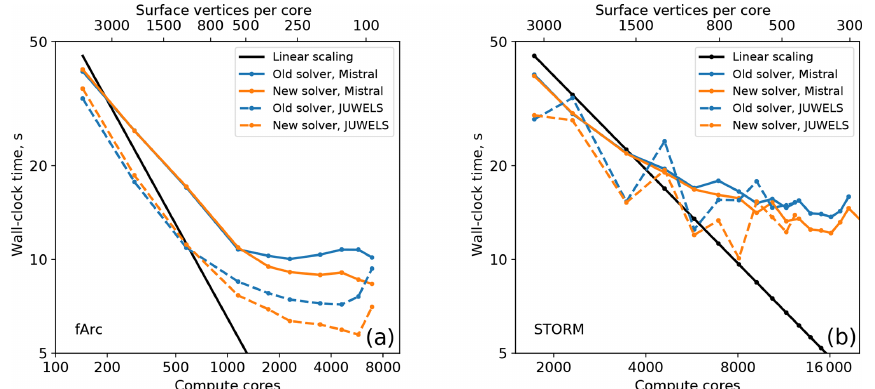
Figure 8. Scaling results for old (Algorithm 2) and new (Algorithm 3) SSH solvers for fArc (a) and STORM (b) meshes on Mistral (DKRZ, Hamburg) and JUWELS (JSC, Jülich) compute